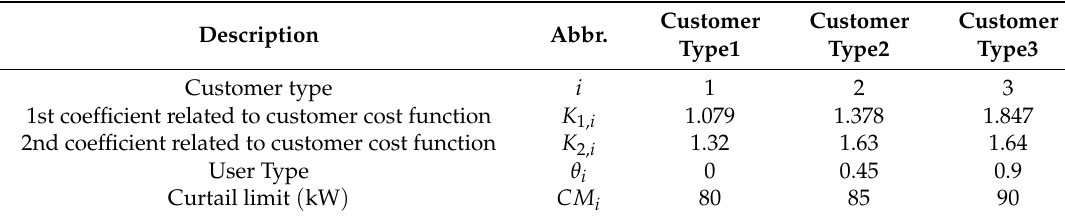
Table 2. Customer cost function related data. Figure 3. Load curve.